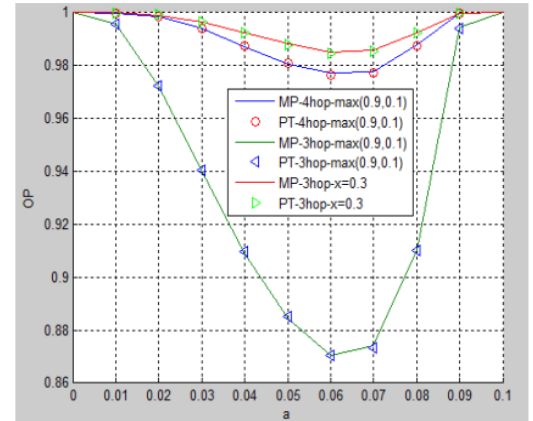
Fig. 6. Pout versus a(s): K=3, K=4,(x PU , y PU )